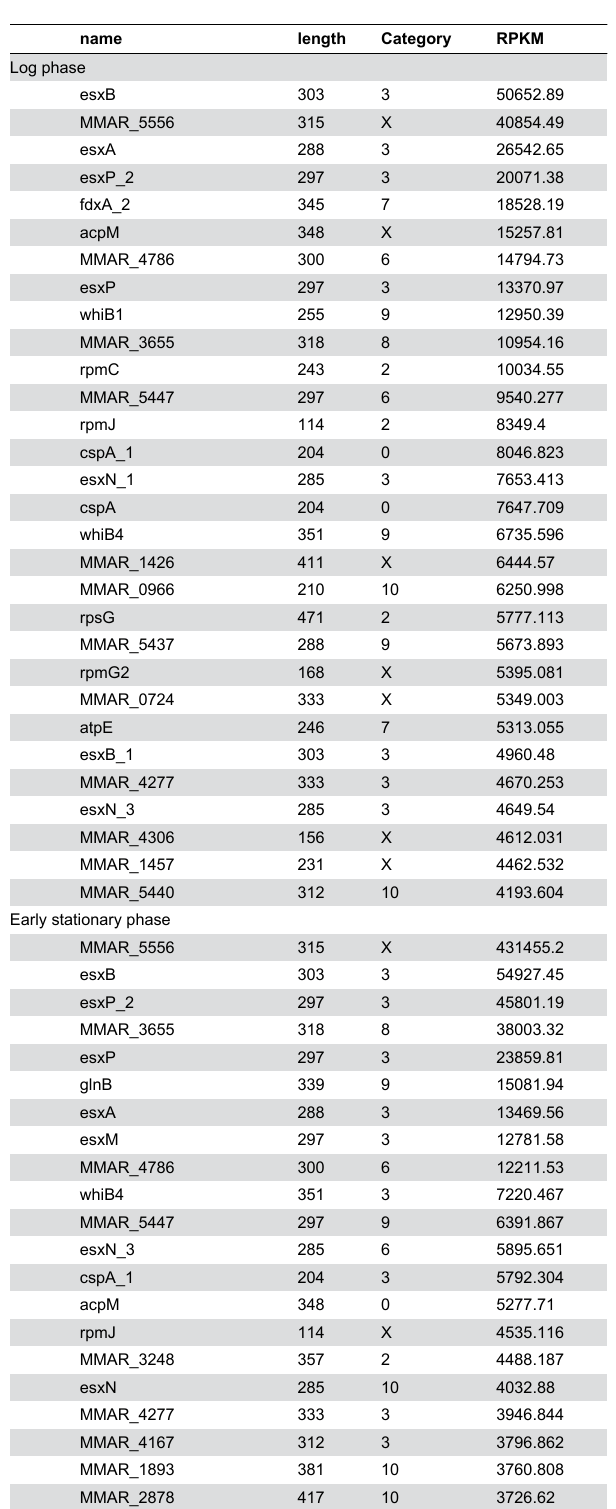
Table 1. Ranking of the most abundant coding transcripts in log and early stationary phase.